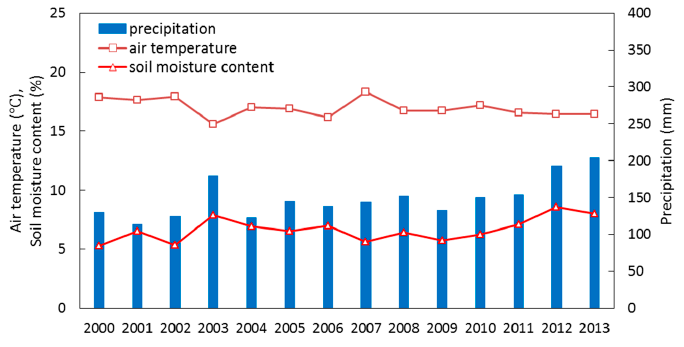
Figure 2. Time series of the climate data for air temperature (°C: red open squares), precipitation (mm: blue bars) and soil moisture content (%: light red open triangles) averages over the sixteen stations during the growing season of 2000–2013.